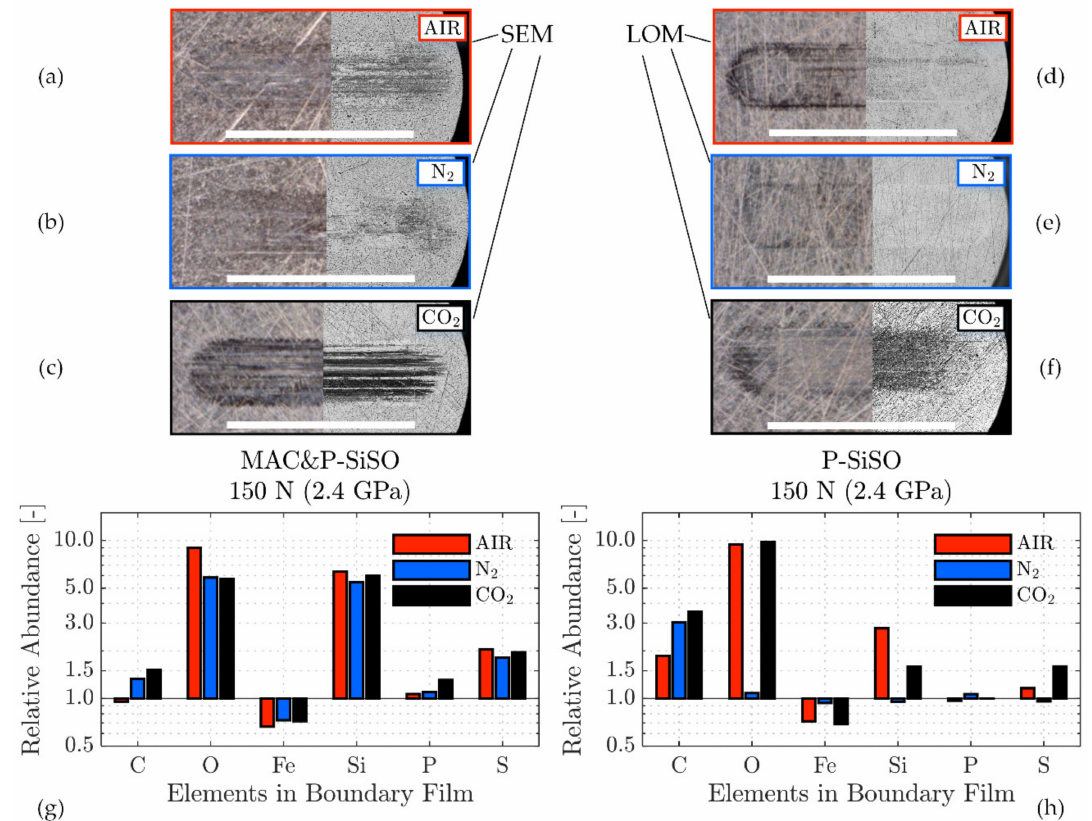
Figure 10. Boundary film analysis of SRV-3 steel discs. ( a – f ) Complementary microscopic techniques (left part light optical microscopy (LOM) and right part SEM) indicate the boundary films coverage in the wear scars lubricated with ‘MAC &P-SiSO’ ( a – c ) and neat P-SiSO ( d – e ) under conditions {150 N/2.4 GPa/AIR}, {150 N/2.4 GPa/N 2 }, {150 N/2.4 GPa/CO 2 }. ( g – h ) Relative abundance (in relation to unworn Reference) of elements detected in the boundary films when lubricated with ‘MAC &P-SiSO’ ( g ) or neat P-SiSO ( h